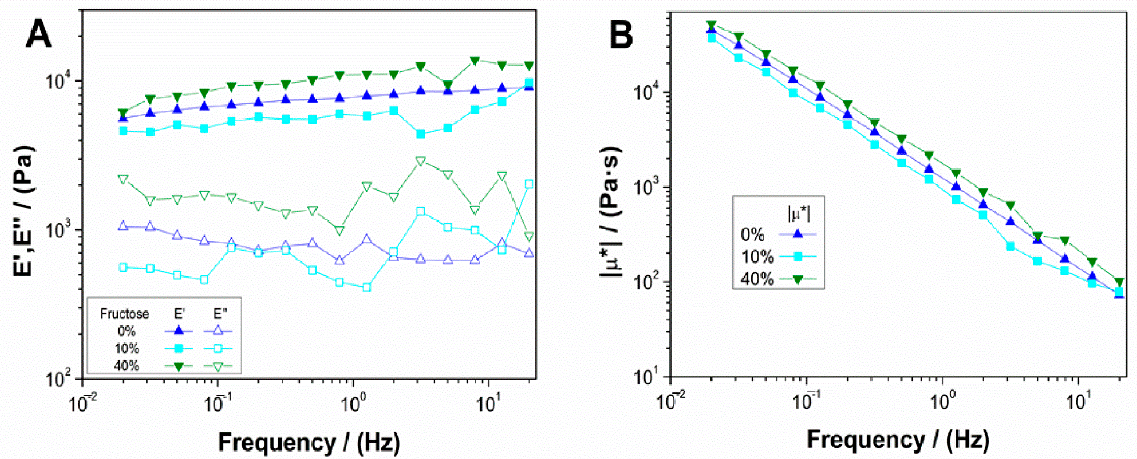
Figure 3. Evolution of ( A ) elastic and viscous moduli and ( B ) complex viscosity for 10 mg/mL collagen-based aerogels with different concentrations of fructose (0, 10 and 40 wt.%).